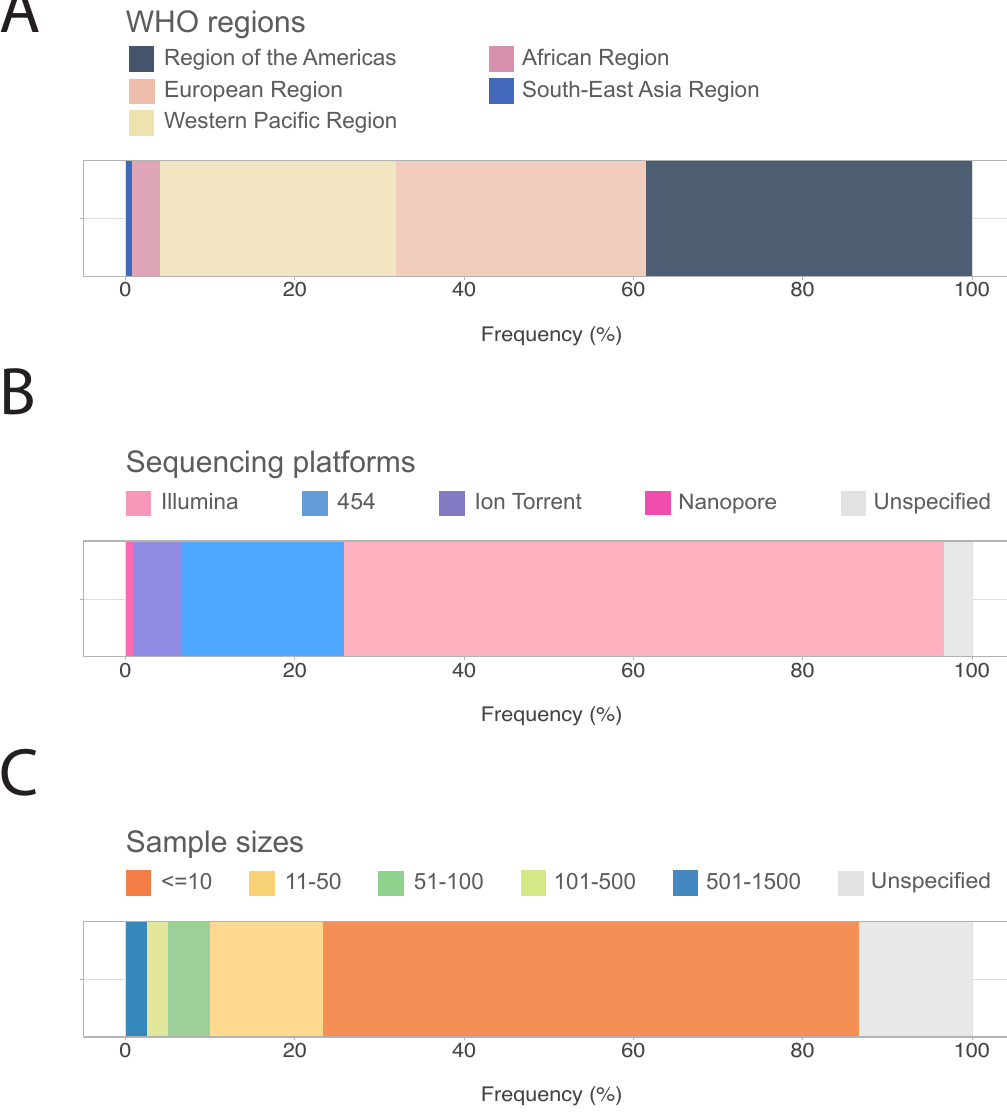
Figure 3. ( A ) Geographical origin of included studies stratified by World Health Organization (WHO) regions. ( B ) An overview of sequencing platforms. ( C ) An overview of sample